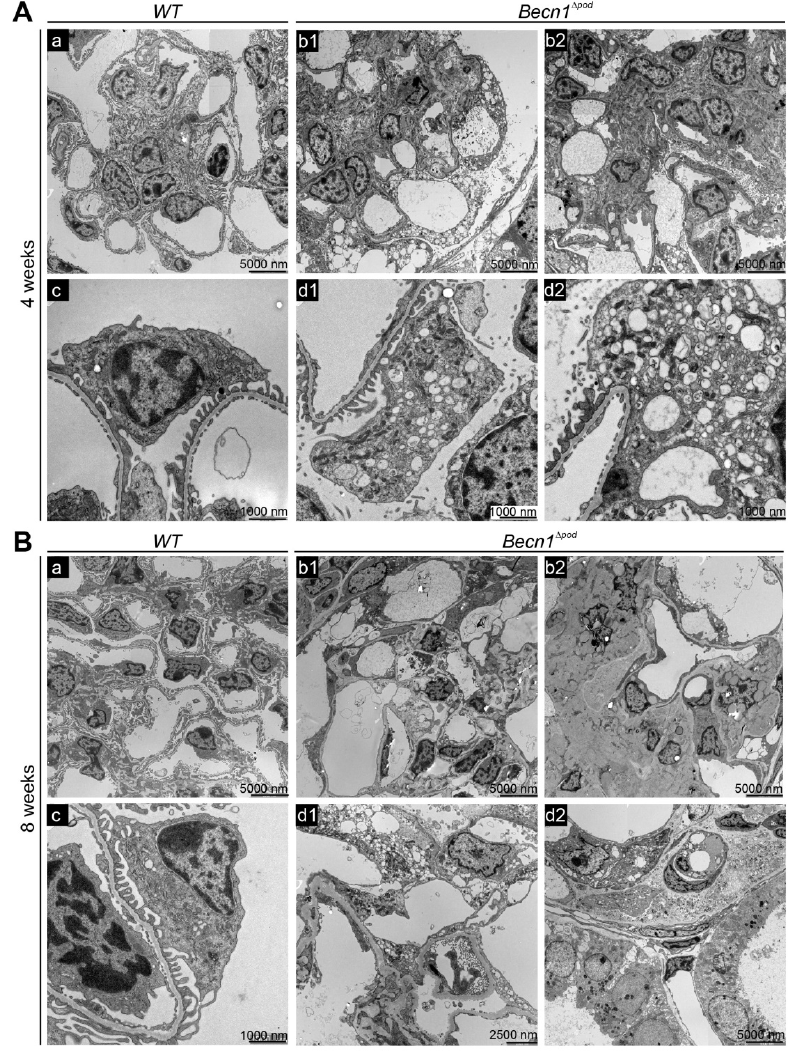
Figure 4. Becn1 ∆ pod mice displaying aberrant vesicle accumulation and flattened podocyte foot processes. ( A ) Transmission electron microscopy (TEM) images showing glomeruli ( a , b1 , b2 ) and podocytes ( c , d1 , d2 ) in kidney sections obtained from 4-week-old WT and Becn1 ∆ pod mice; ( B ) TEM images showing glomeruli ( a , b1 , b2 ) and podocytes ( c , d1 , d2 ) in kidney sections obtained from 8- week-old WT and Becn1 ∆ pod mice.